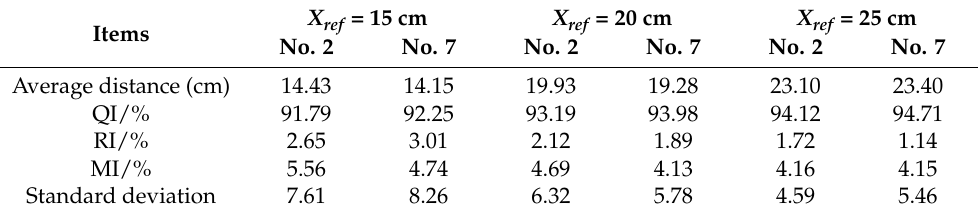
Table 6. Seeding performance for different driving